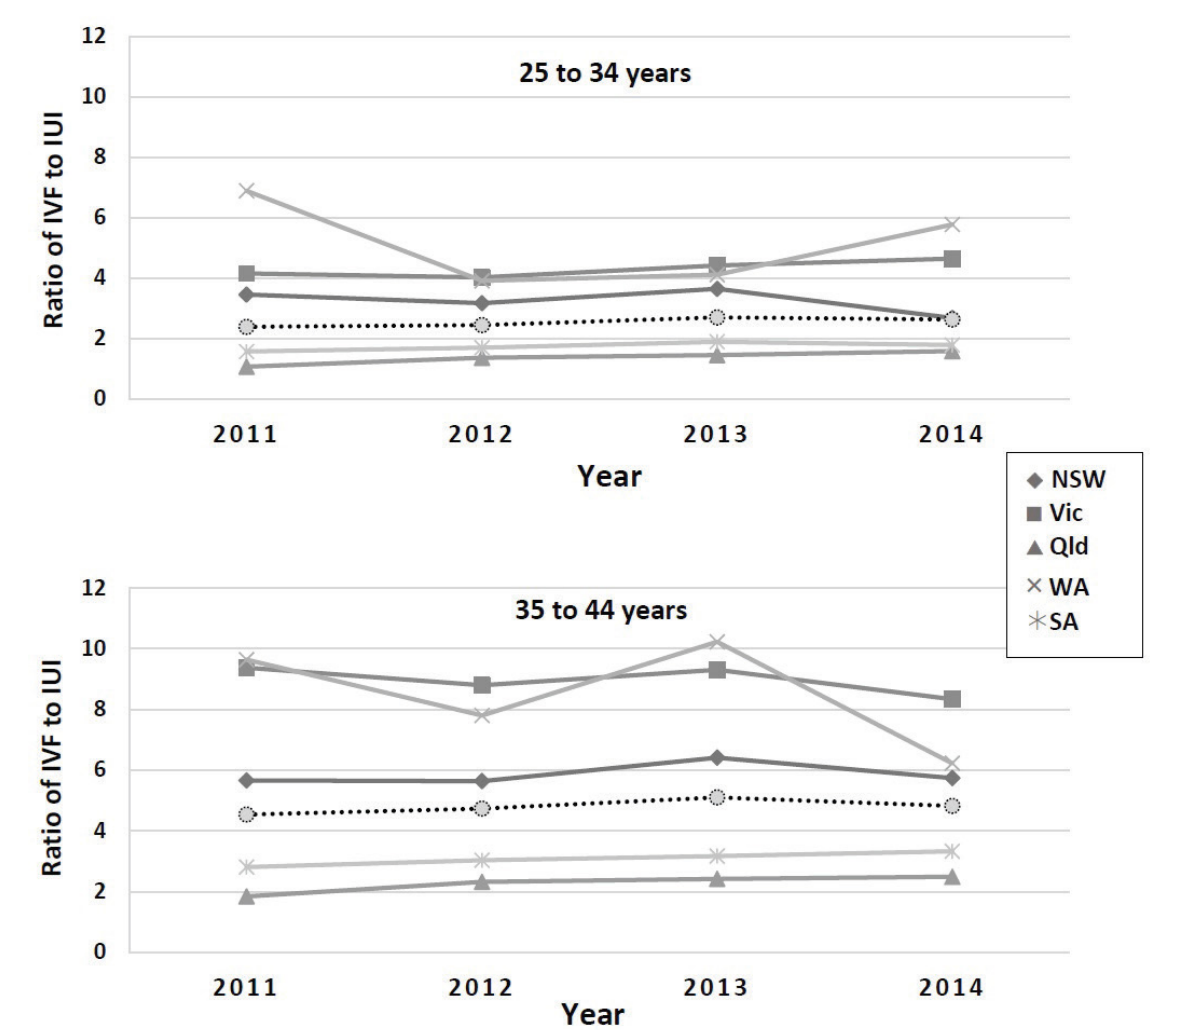
Figure 5. Age-stratified ratio of IVF cycles versus intrauterine insemination IUI cycles in women (a) aged 25 to 34 years and (b) aged 35 to 44 years in Australia, 2011 to 2014 inclusive